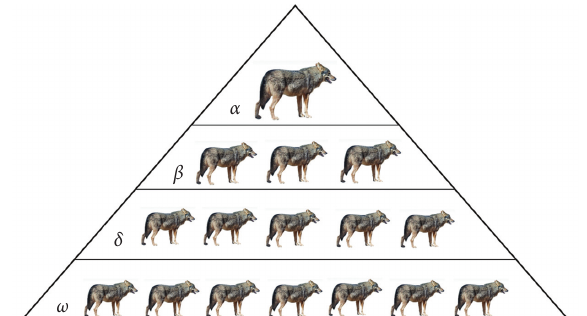
Figure 1: The social hierarchy of gray wolves [13].